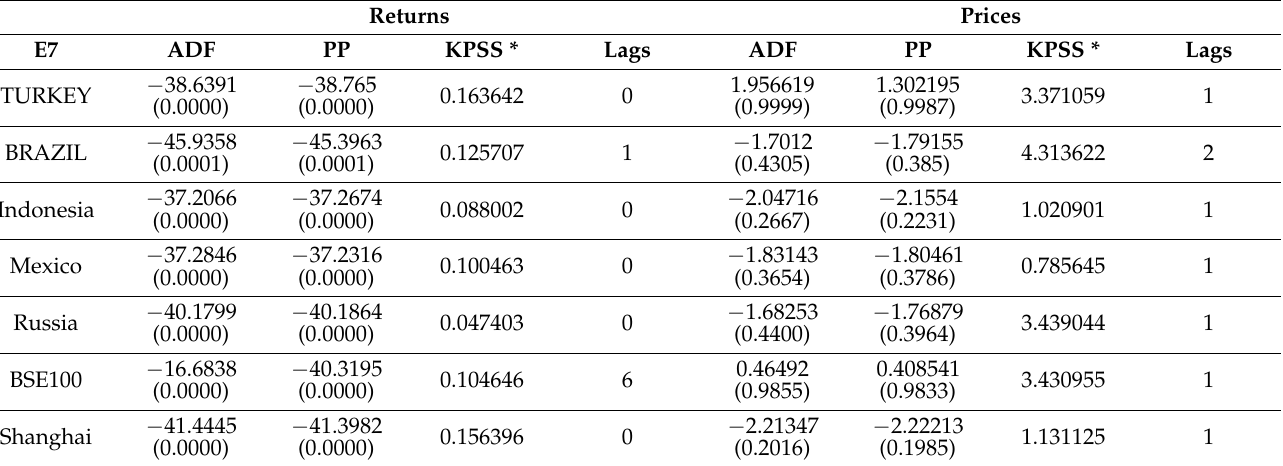
Table 6. E7 Unit Root